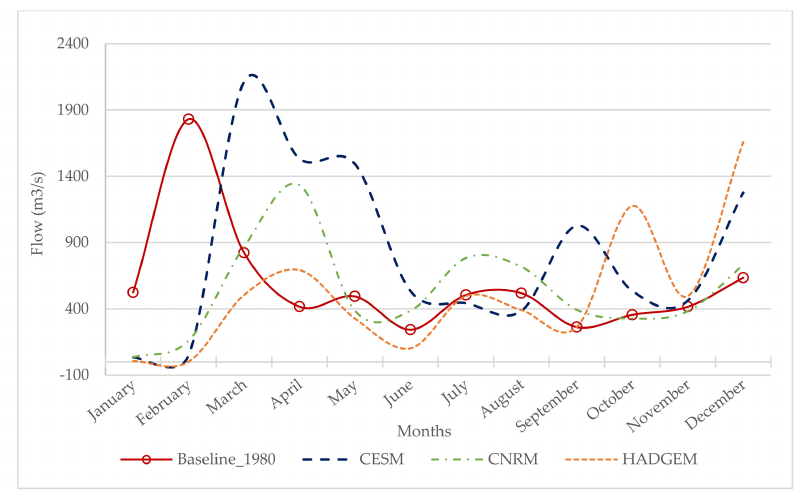
Figure 9. Simulated streamflow for1980 baseline and 2045 climate conditions.